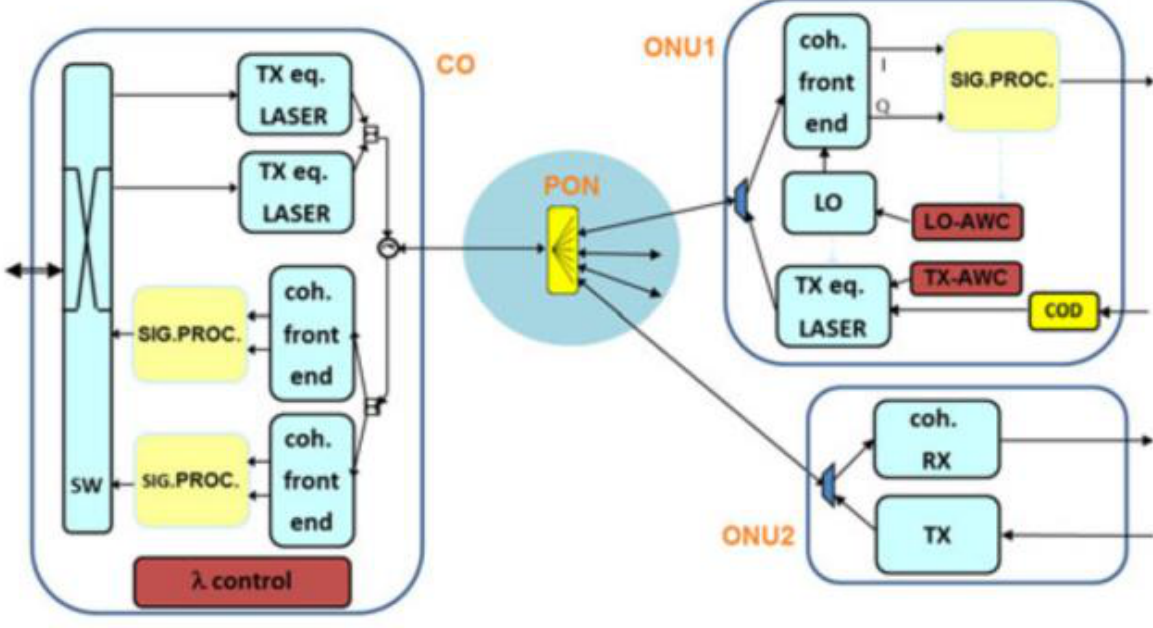
Figure 12. Architecture of a UD-WDM-PON [44].